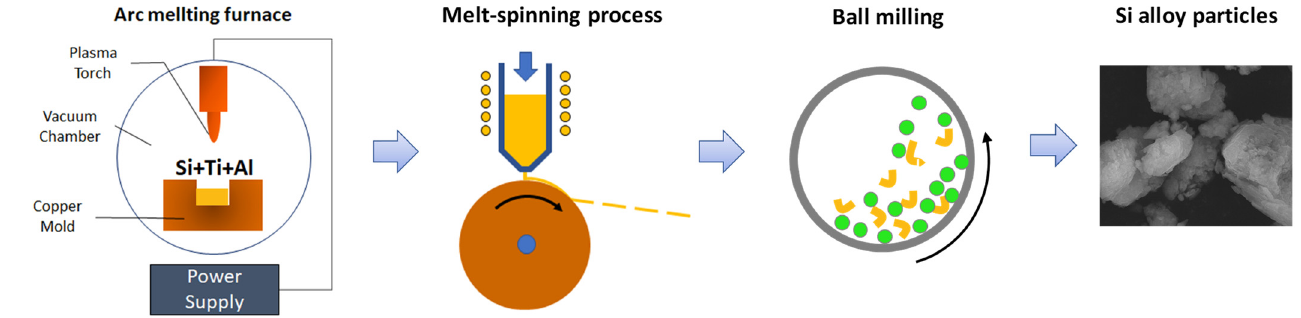
Figure 1. Schematic of the Si-alloy fabrication process.